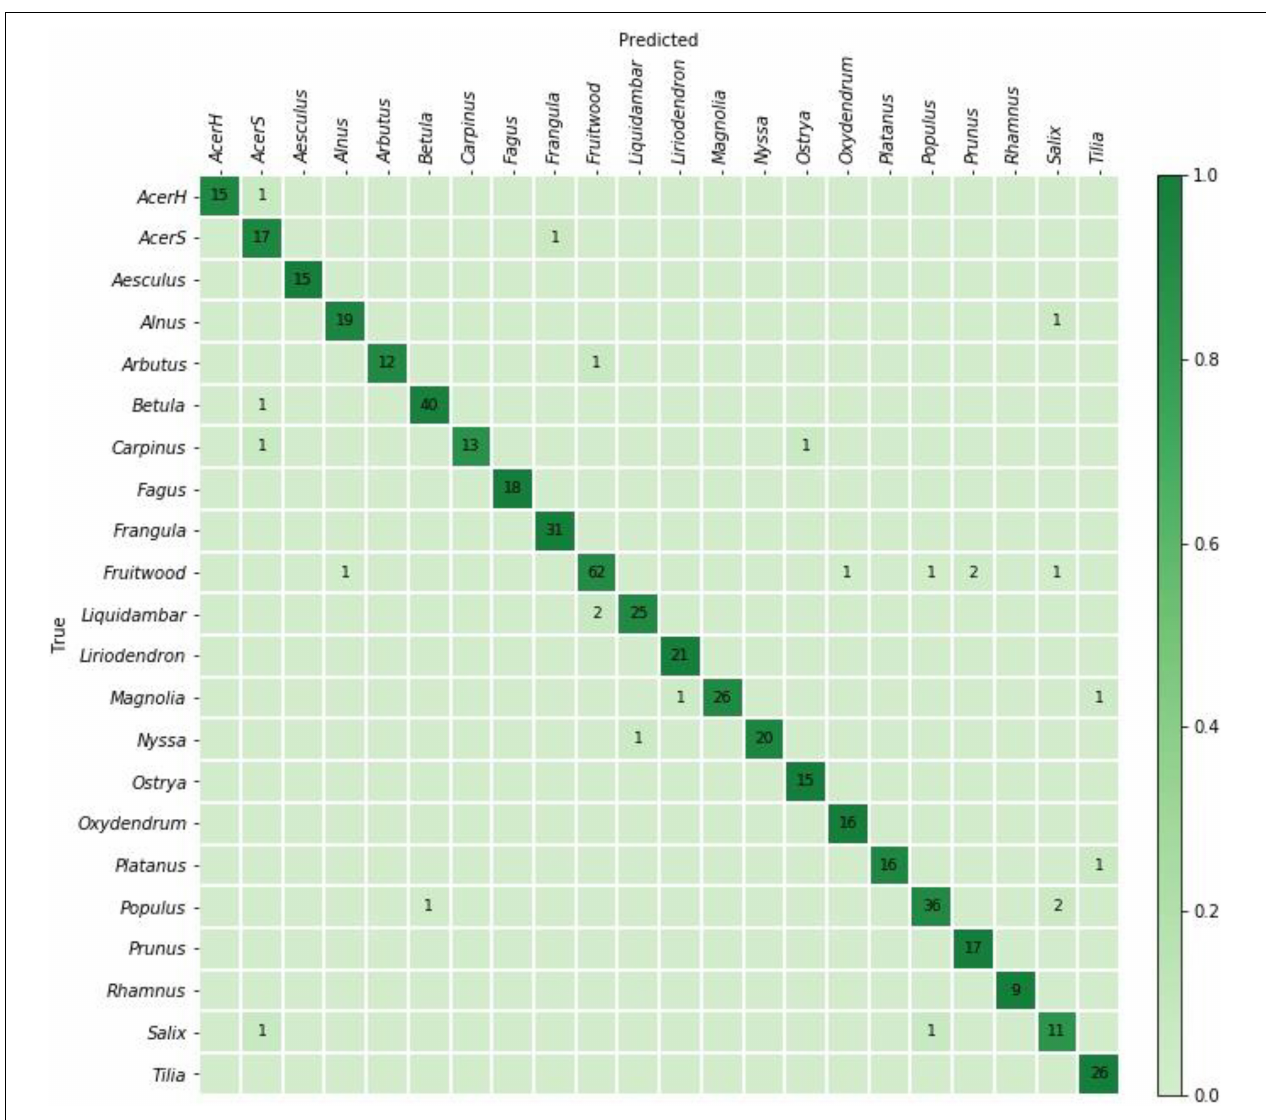
FIGURE 3 | Confusion matrix for the cross-validation model predictions on 504 specimens. The specimen-level top-1 prediction accuracy accumulated over the fivefolds was